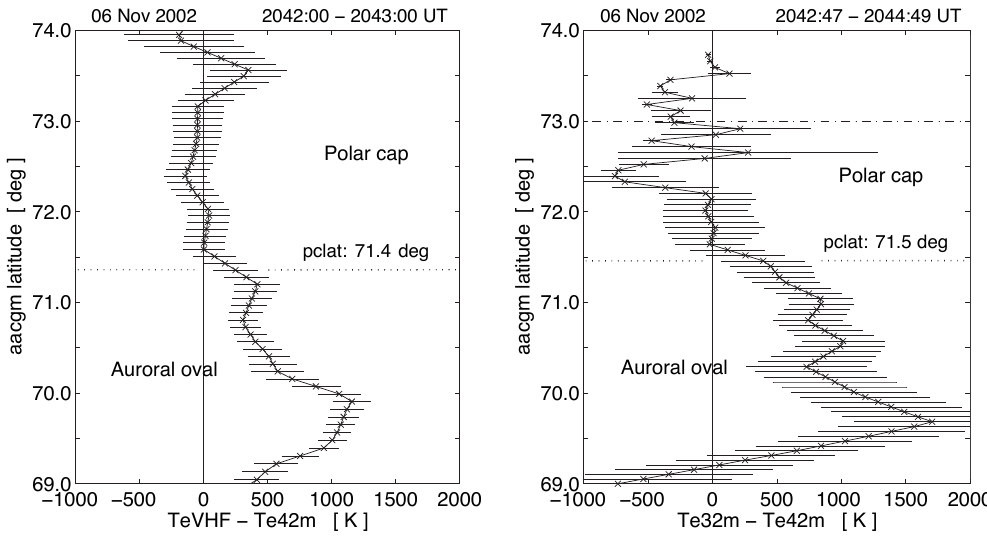
Fig. 3. Left: The polar cap altitude profile of T e by the ESR 42m radar (Fig. 2a) subtracted from the altitude profile of T e by the low-elevation northward pointing VHF radar (Fig. 2b) and the result shown as a function of latitude. Right: The polar cap altitude profile of T e by the ESR 42m radar (Fig. 2a) subtracted from the altitude profile of T e by the southward pointing low-elevation ESR 32m radar as a function of latitude. For the ESR 32m data the highest latitude studied is 73 ◦ , as shown by the dashed line.